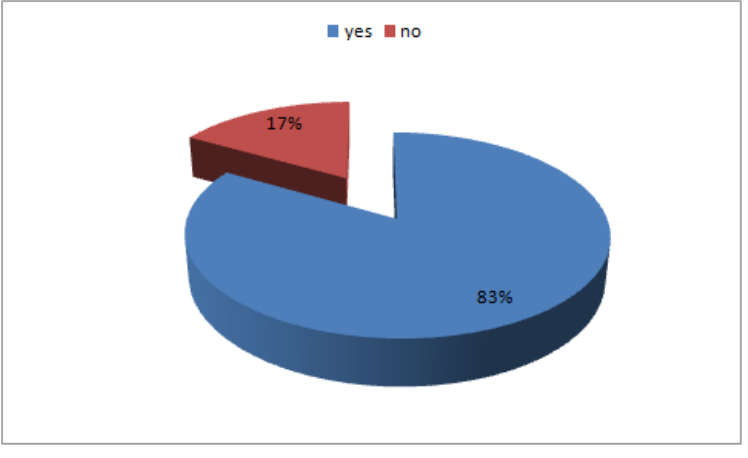
Figure 3: The Usage of Internet Banking